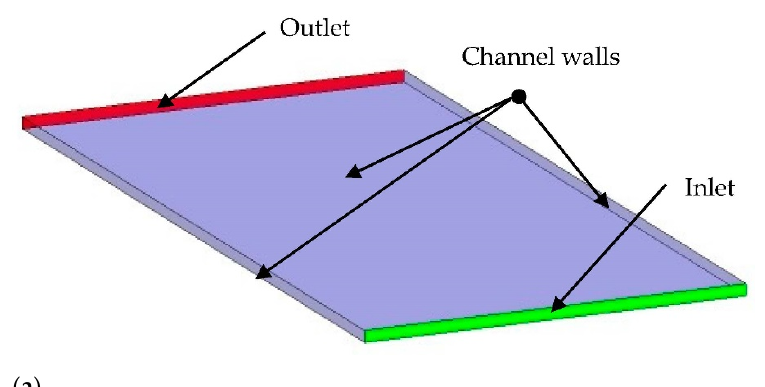
8 of 23 Table 2. Mesh details for the mesh optimization study. Rotating Domain